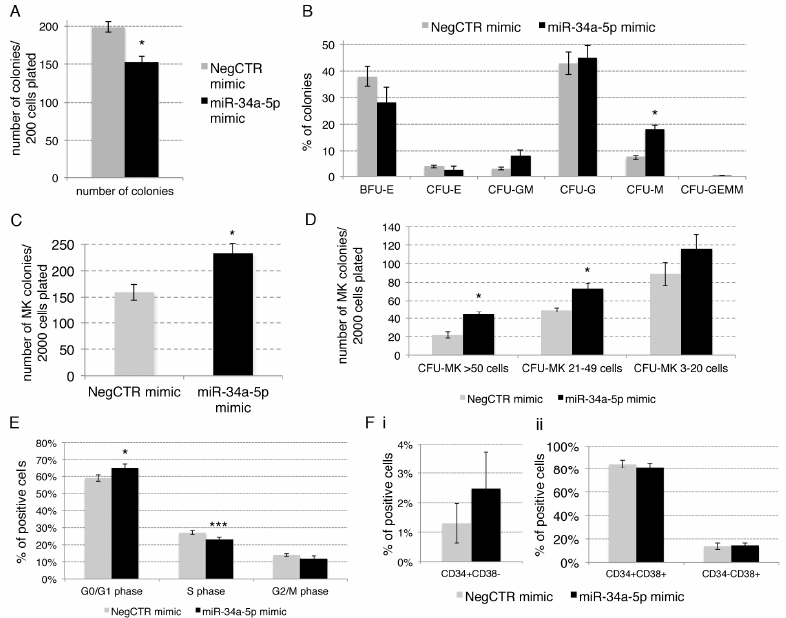
Figure 2. Effects of miR-34a-5p overexpression on CD34+ hematopoietic progenitor cells clonogenic activity, proliferation and commitment. ( A , B ) Methylcellulose clonogenic assay results (mean ± SEM; n = 3). The colony scoring results are reported as total number of colonies grown from 200 cells plated ( A ) and percentages of each colony type ( B ); Colonies were scored according to the manufacturer’s guidelines; ( C , D ) Megakaryocyte clonogenic assay results (mean ± SEM; n = 3) in terms of megakaryocyte colony number ( C ) and size ( D ); Values are reported as number of megakaryocyte colonies for 2000 plated cells; ( E ) Statistical analysis results (mean ± SEM; n = 3) for the percentage of cells in the different cell cycle phases performed by propidium iodide staining 24 h post-nucleofection; ( F ) Flow cytometric detection (mean ± SEM; n = 3) of the CD34+CD38 − hematopoetic stem cell fraction ( Fi ) and the CD34+CD38+ and CD34 − CD38+ hematopoietic progenitor cell populations ( Fii ) at 24 h post-nucleofection. Data are from n = 3 independent experiments performed with different healthy donor-derived cord blood units. Error bars in the graphs represent SEM. * p ≤ 0.05 and *** p ≤ 0.001 vs. NegCTR mimic sample.